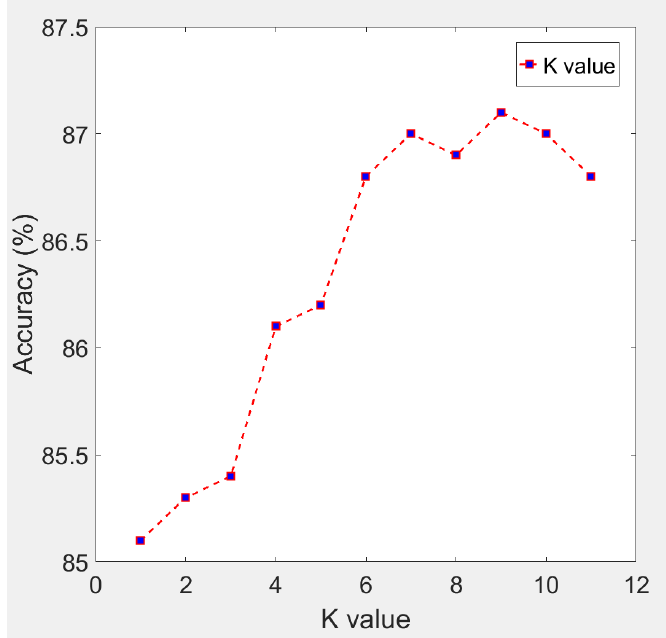
Figure 8. Cross-validation result. Multi-class SVM showed the highest accuracy when K value was 10.